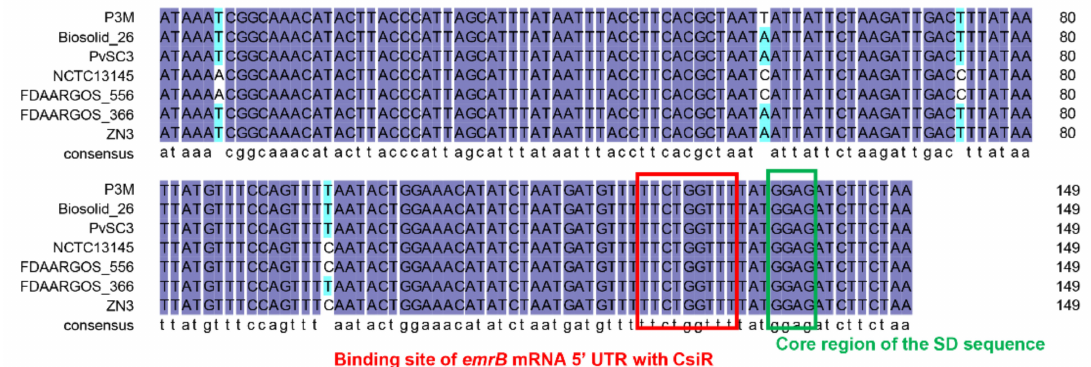
Figure 11. Sequence alignment of emrB mRNA 5 (cid:48) UTR in P3M with homologous sequences in all sequenced P. vulgaris strains. Sequences marked with red and green boxes are the binding sites of emrB mRNA interacting with CsiR and the core region of the SD sequence,